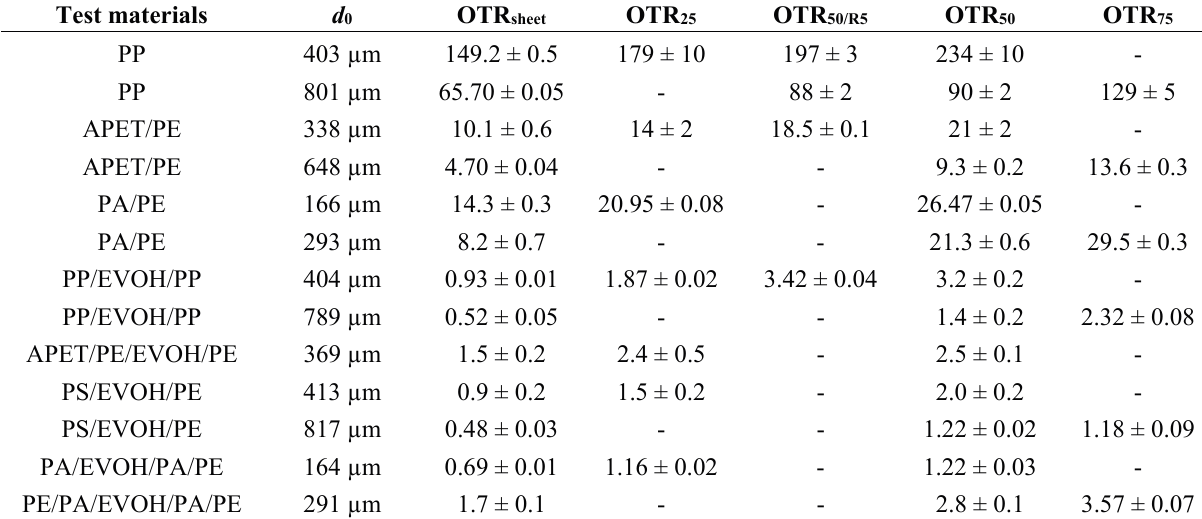
Table 4. Mean OTR ± standard deviation ( n = 2–3) of tested sheets and trays, expressed in cc/m 2